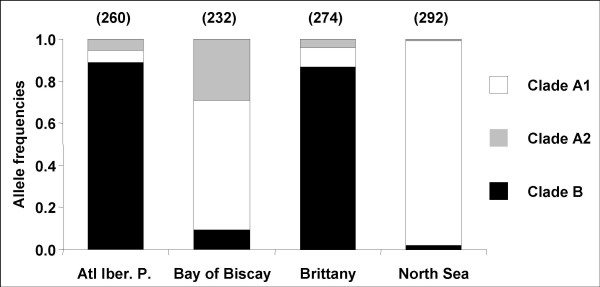
Allelic frequencies of clades A1 (white), A2 (grey) and B (black) deduced for allele-size frequencies. Atl. Iberian P.: M. galloprovincialis populations of the Atlantic coast of the Iberian Peninsula (samples FA, 1, 2 an 3 in Figure 1); Bay of Biscay: M. edulis populations of the Bay of Biscay (samples LU, 4 and 5 in Figure 1); Brittany: M. galloprovincialis populations of Brittany (Samples PR, 6, 7 and 8 in Figure 1); North Sea: M. edulis populations of the North Sea (samples WS, 9, 10 and 11 in Figure 1). The number of sampled alleles (equivalent to twice the number of individuals) is given within brackets above each histogram.